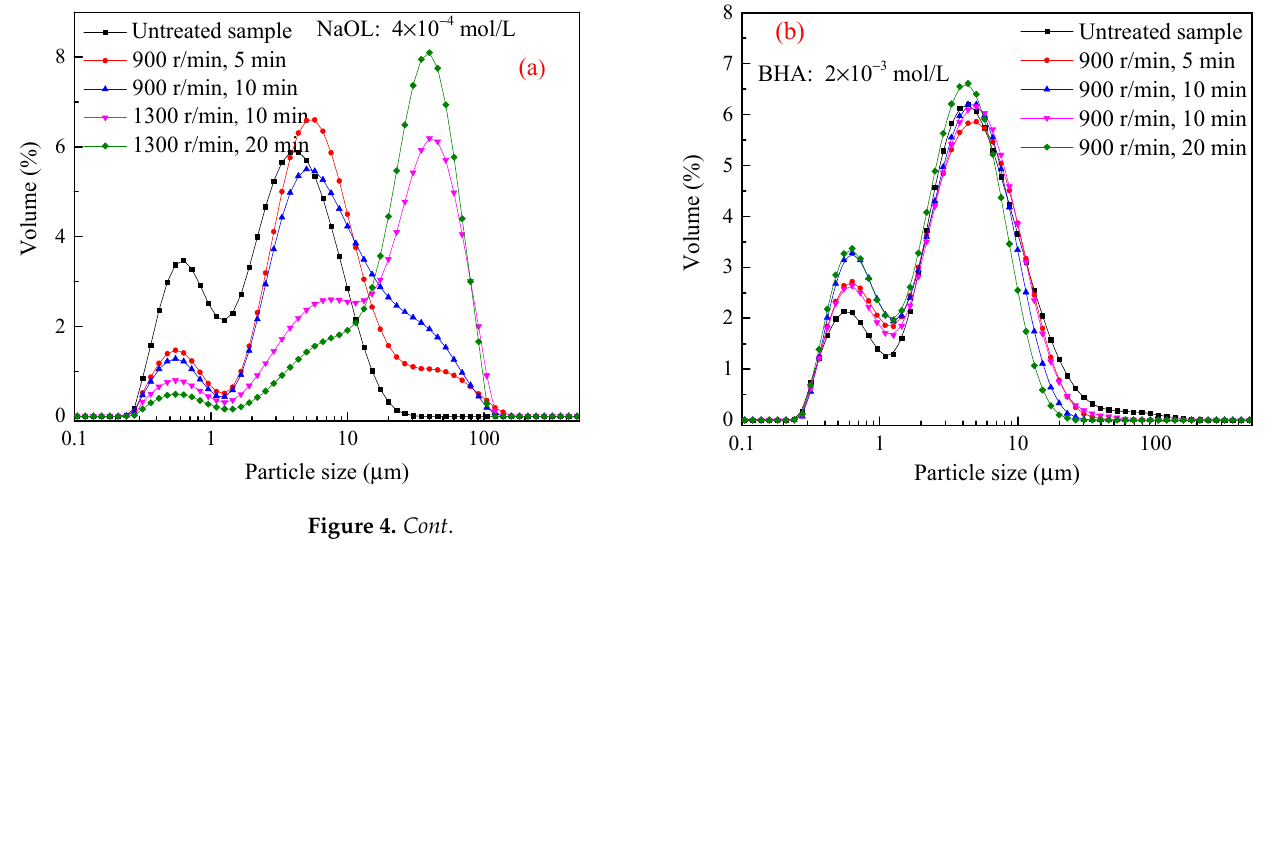
Figure 3. Effect of NaOL ( a ) and BHA ( b ) concentrations on the flotation recovery of − 23 μ m cassit- erite (pH = 8.5).